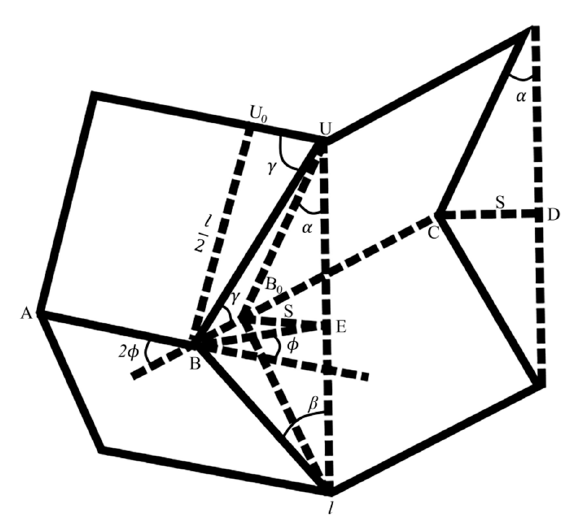
Figure A3. Basic folding element